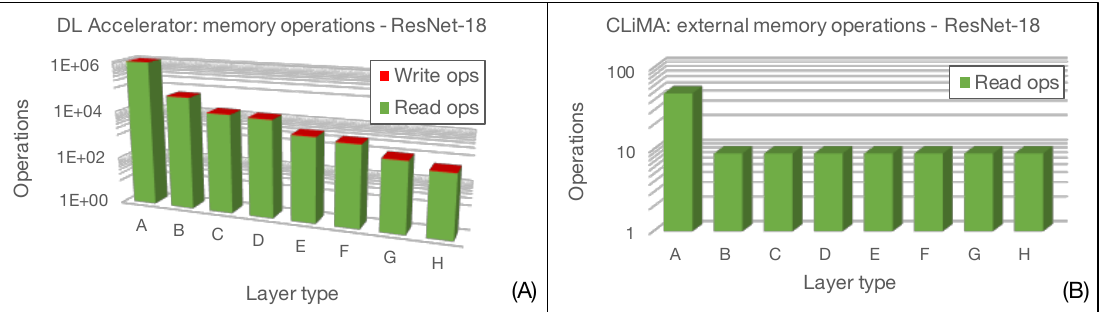
Figure 18. Memory access evaluation for AlexNet in ( A ) Deep Learning Accelerator and ( B ) CLiMA.